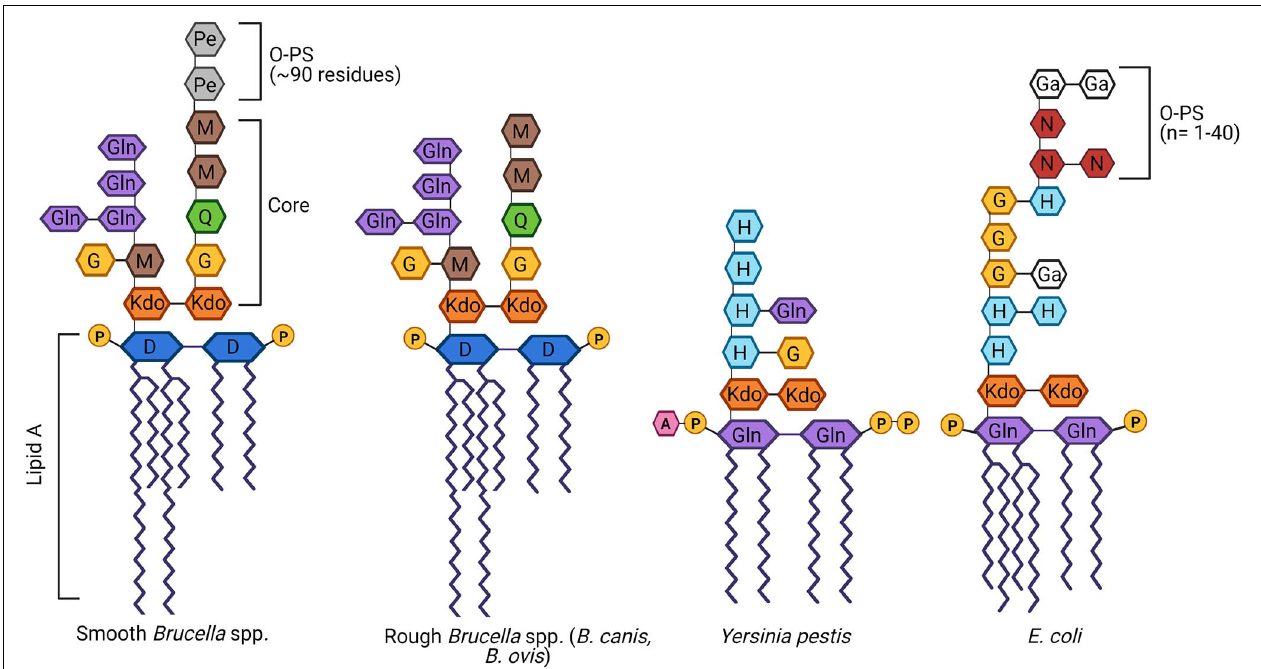
FIGURE 1 | Schematic of the structure of lipopolysaccharide (LPS) of Brucella spp. in comparison to other Gram-negative bacteria. Brucella LPS is unusual in several ways, including the incorporation of very long chain fatty acids (VLCFAs) in the lipid A and a core oligosaccharide side branch composed of several glucosamine residues. In contrast, most other Gram-negative bacteria, best exemplified by Escherichia coli, possess a more compact lipid A and no core side branches. Brucella spp. may be categorized as smooth if they possess an intact O-polysaccharide (O-PS), as is the case with most zoonotic strains. Alternatively, Brucella canis and Brucella ovis are naturally rough, completely lacking the O-PS. While typically associated with attenuation, both rough Brucella spp. remain fully virulent in their natural hosts, as does the naturally rough Yersinia pestis . D, diaminoglucose; G, glucose; Ga, galactose; Gln, glucosamine; H, heptose; 3-deoxy- D -mannose-2-octulosonic acid, Kdo; M, mannose; N, N -acetylglucosamine; Pe, N -formylperosamine; Q, quinovosamine. Adapted from Mancilla (2015), Yang et al. (2019), and Singh et al. (2020). Created with